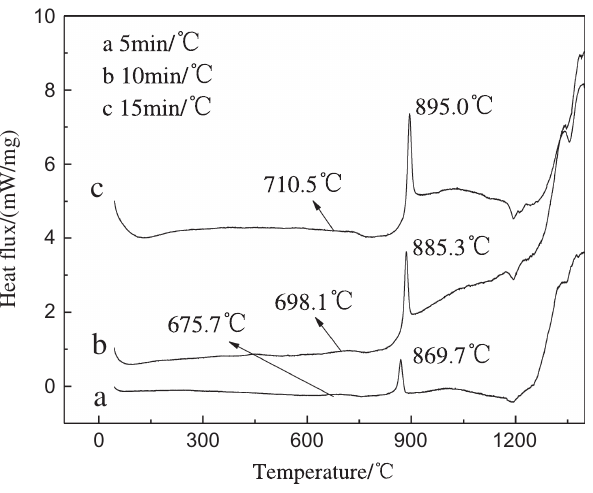
Figure 2: DSC curve of fibers at the acidity coefficient of